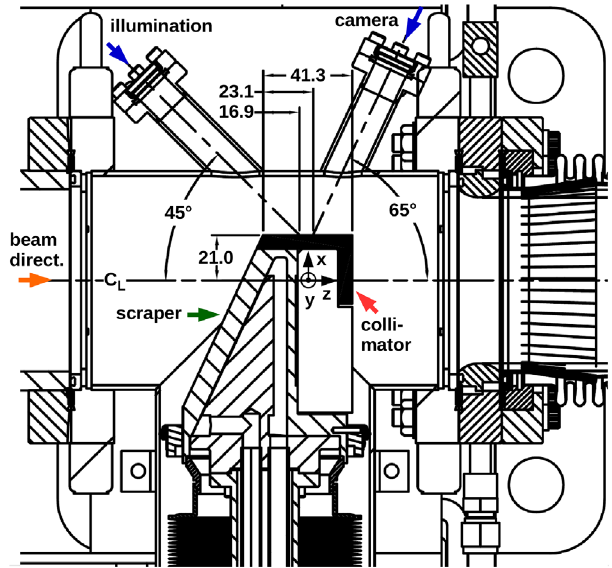
FIG. 10. Dose map at the collimator apex for a 200-mA, whole- beam dump from the January 2020 experiment simulating the eighth loss event (SN08). Note the increased size of the footprint relative to the APS-U case presented in Fig. 9. The x- and y-dose profiles plotted at the location of maximum integrated dose yield FWHM x ¼ 132 . 1 μ m and FWHM y ¼ 43 . 9 μ m.